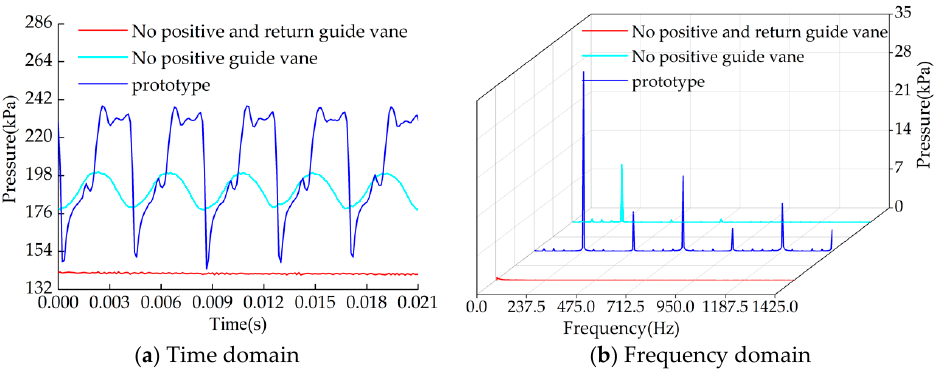
Figure 7. Time and frequency response curves of pressure inside the impeller for different blade numbers of the guide vane.